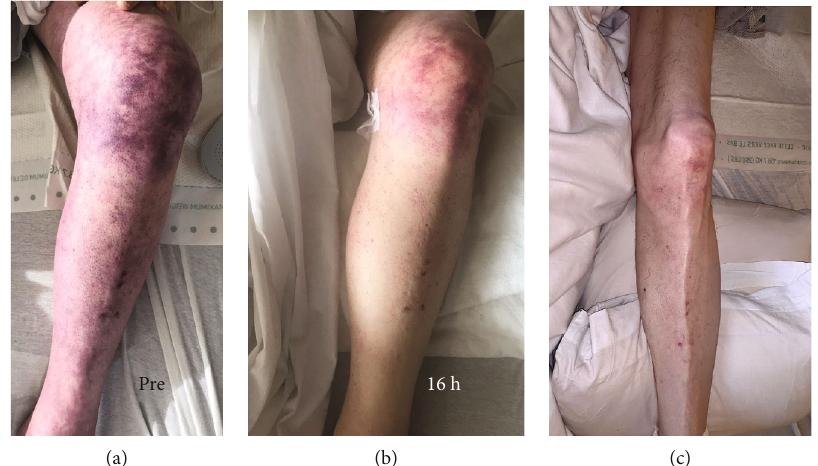
Figure 1: Left lower extremity: (a) at the time of diagnosis of phlegmasia cerulea dolens; (b) 16 hours after thrombectomy; (c) at one-month